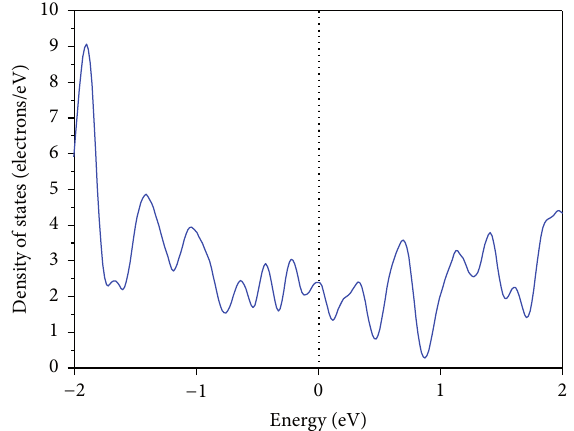
Figure 6: Density of states (DOS) of N2-doped single walled arm- chair (3,3) boron nanotube. The Fermi energy is set corresponding to zero energy and represented by dotted